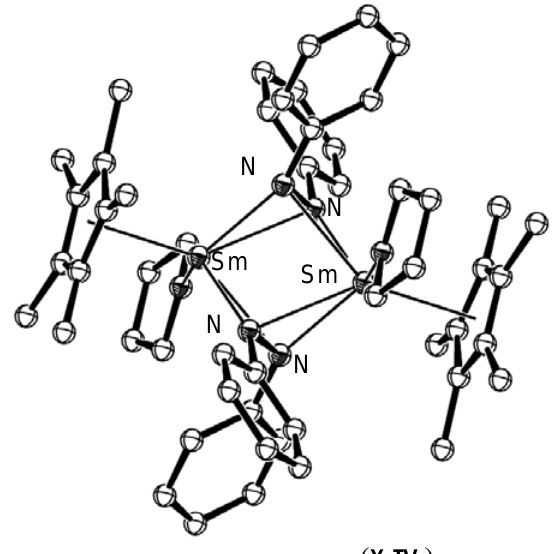
Figure 12. Molecular structure of [{(C Figure generated from CCDC obtained coordinates. Atoms of arbitrary size. H atoms are omitted for clarity.